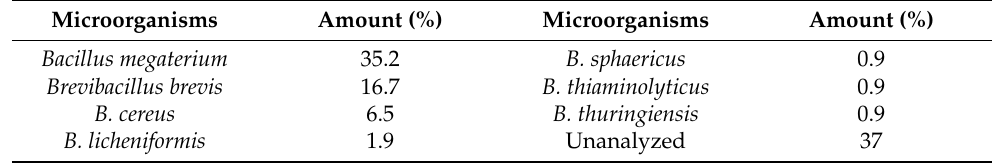
Table 2. Relative amounts of each genus of spore species (rod-shaped bacterium) in the sample pills. Microorganisms